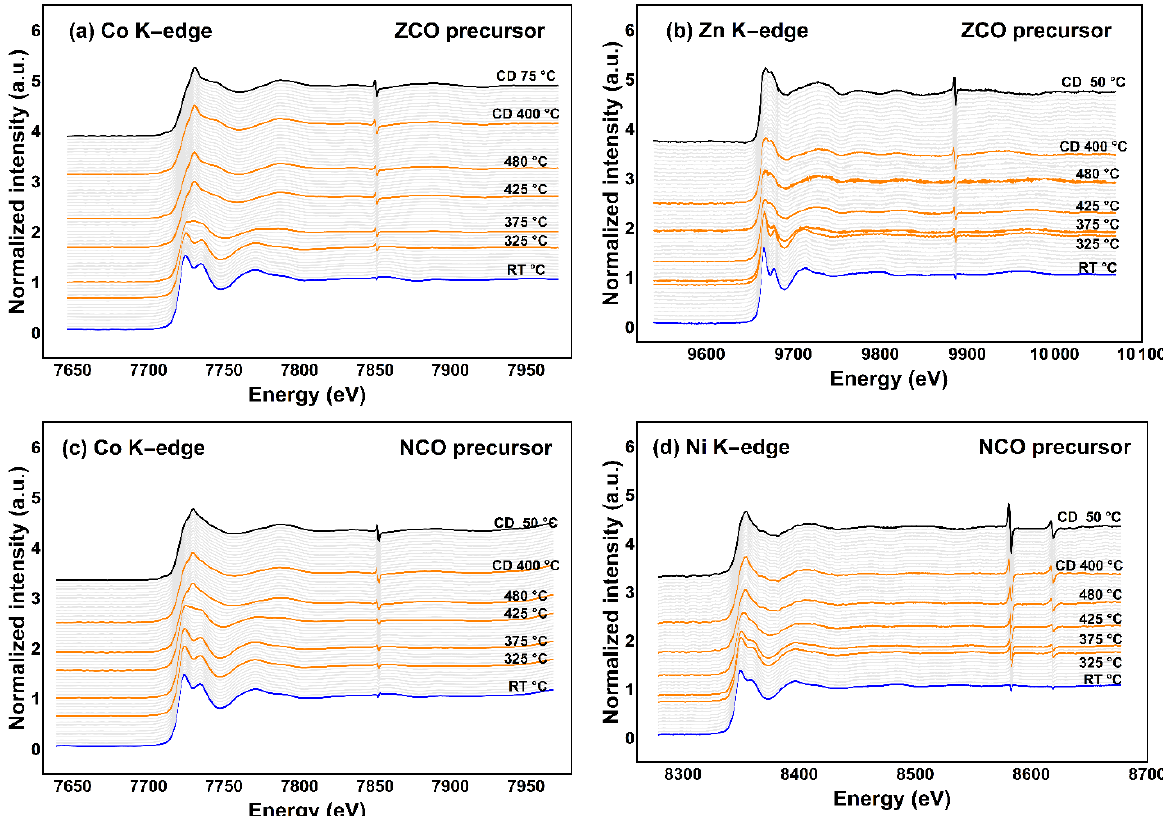
Figure 5. TRXAS K-edge spectra of metal species in two different spinel precursors; ( a ) cobalt and ( b ) zinc in the ZCO precursor; ( c ) cobalt, and ( d ) nickel in the NCO precursor.